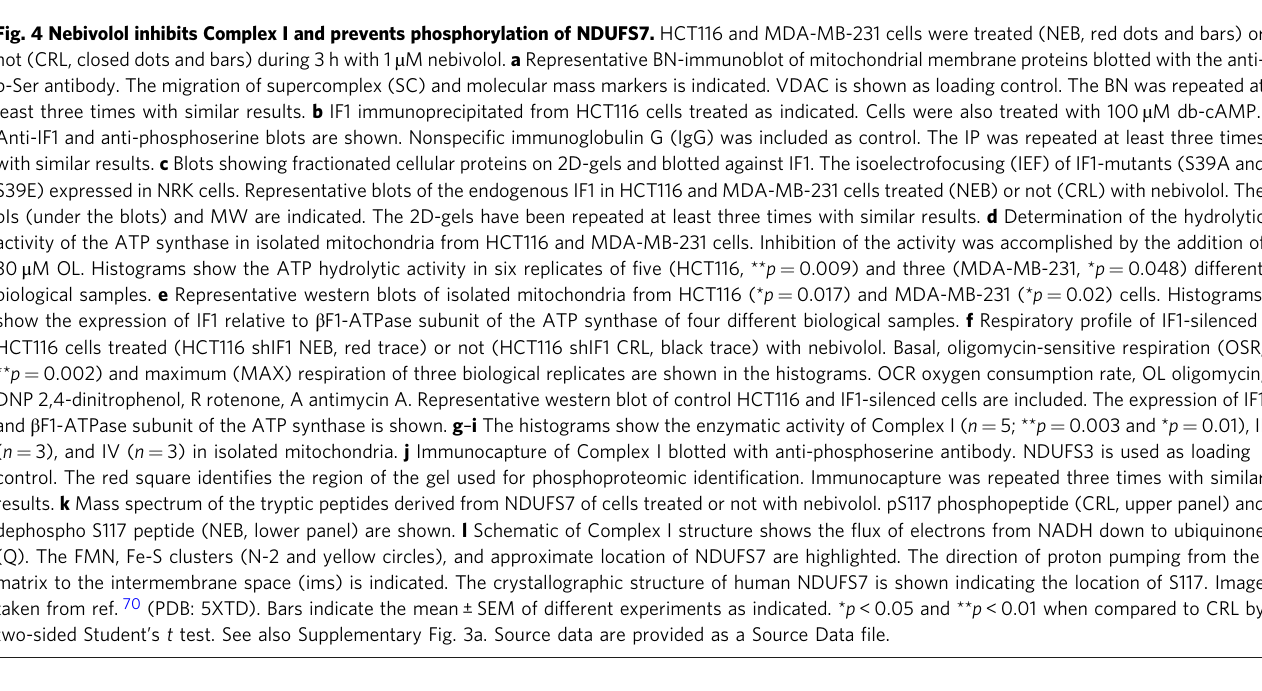
Fig. 4 Nebivolol inhibits Complex I and prevents phosphorylation of NDUFS7. HCT116 and MDA-MB-231 cells were treated (NEB, red dots and bars) or not (CRL, closed dots and bars) during 3 h with 1 µ M nebivolol. a Representative BN-immunoblot of mitochondrial membrane proteins blotted with the anti- p-Ser antibody. The migration of supercomplex (SC) and molecular mass markers is indicated. VDAC is shown as loading control. The BN was repeated at least three times with similar results. b IF1 immunoprecipitated from HCT116 cells treated as indicated. Cells were also treated with 100 µ M db-cAMP. Anti-IF1 and anti-phosphoserine blots are shown. Nonspeci fi c immunoglobulin G (IgG) was included as control. The IP was repeated at least three times with similar results. c Blots showing fractionated cellular proteins on 2D-gels and blotted against IF1. The isoelectrofocusing (IEF) of IF1-mutants (S39A and S39E) expressed in NRK cells. Representative blots of the endogenous IF1 in HCT116 and MDA-MB-231 cells treated (NEB) or not (CRL) with nebivolol. The pIs (under the blots) and MW are indicated. The 2D-gels have been repeated at least three times with similar results. d Determination of the hydrolytic activity of the ATP synthase in isolated mitochondria from HCT116 and MDA-MB-231 cells. Inhibition of the activity was accomplished by the addition of 30 μ M OL. Histograms show the ATP hydrolytic activity in six replicates of fi ve (HCT116, ** p = 0.009) and three (MDA-MB-231, * p = 0.048) different biological samples. e Representative western blots of isolated mitochondria from HCT116 (* p = 0.017) and MDA-MB-231 (* p = 0.02) cells. Histograms show the expression of IF1 relative to β F1-ATPase subunit of the ATP synthase of four different biological samples. f Respiratory pro fi le of IF1-silenced HCT116 cells treated (HCT116 shIF1 NEB, red trace) or not (HCT116 shIF1 CRL, black trace) with nebivolol. Basal, oligomycin-sensitive respiration (OSR, ** p = 0.002) and maximum (MAX) respiration of three biological replicates are shown in the histograms. OCR oxygen consumption rate, OL oligomycin, DNP 2,4-dinitrophenol, R rotenone, A antimycin A. Representative western blot of control HCT116 and IF1-silenced cells are included. The expression of IF1 and β F1-ATPase subunit of the ATP synthase is shown. g – i The histograms show the enzymatic activity of Complex I ( n = 5; ** p = 0.003 and * p = 0.01), II ( n = 3), and IV ( n = 3) in isolated mitochondria. j Immunocapture of Complex I blotted with anti-phosphoserine antibody. NDUFS3 is used as loading control. The red square identi fi es the region of the gel used for phosphoproteomic identi fi cation. Immunocapture was repeated three times with similar results. k Mass spectrum of the tryptic peptides derived from NDUFS7 of cells treated or not with nebivolol. pS117 phosphopeptide (CRL, upper panel) and dephospho S117 peptide (NEB, lower panel) are shown. l Schematic of Complex I structure shows the fl ux of electrons from NADH down to ubiquinone (Q). The FMN, Fe-S clusters (N-2 and yellow circles), and approximate location of NDUFS7 are highlighted. The direction of proton pumping from the matrix to the intermembrane space (ims) is indicated. The crystallographic structure of human NDUFS7 is shown indicating the location of S117. Image taken from ref. 70 (PDB: 5XTD). Bars indicate the mean ± SEM of different experiments as indicated. * p < 0.05 and ** p < 0.01 when compared to CRL by two-sided Student ’ s t test. See also Supplementary Fig. 3a. Source data are provided as a Source Data fi